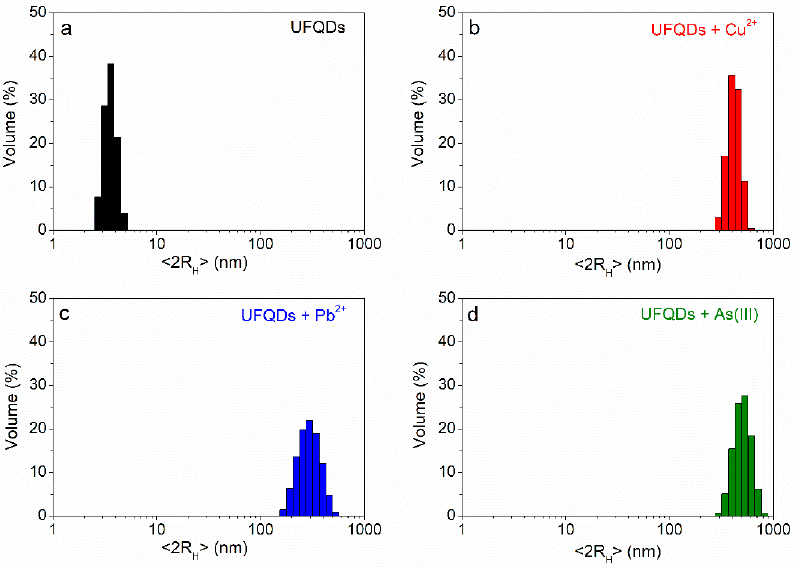
Figure 6. Particle size distribution of UFQDs as determined by dynamic light scattering: ( a ) in the absence of any ion: <2R H > = 3.5 ± 1.0 nm; ( b ) in the presence of 100 μ M of Cu 2+ : <2R H > = 420 ± 25 nm;